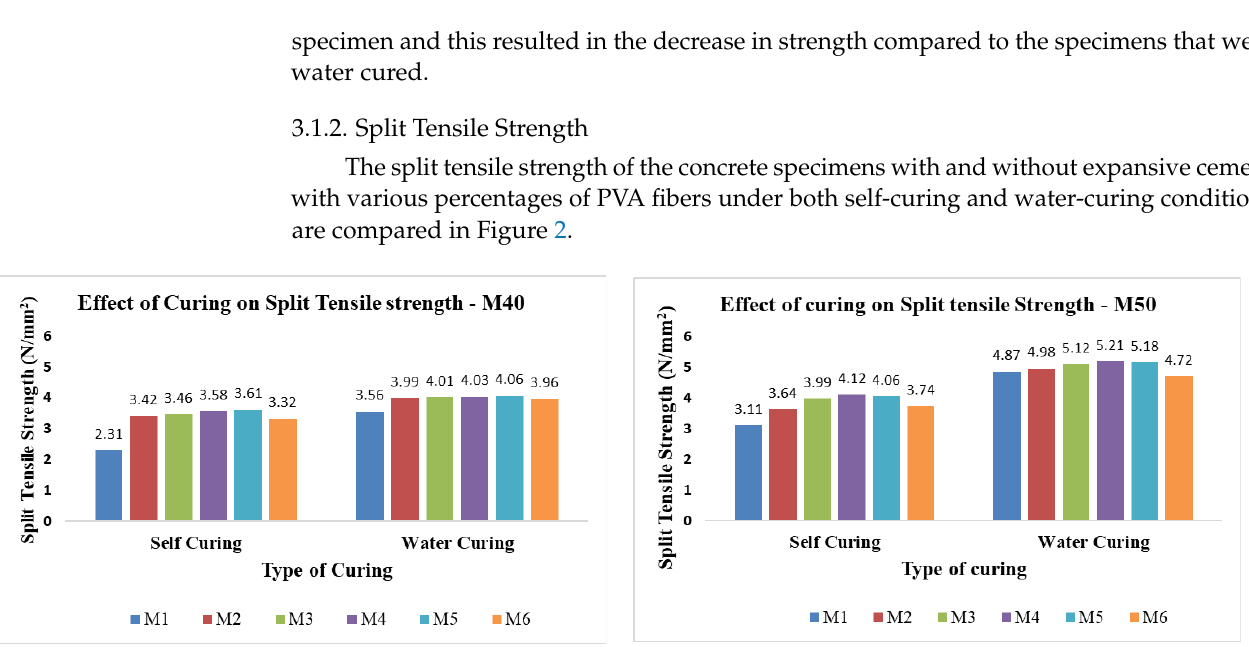
Figure 2. Impact of curing on split tensile strength of concrete.